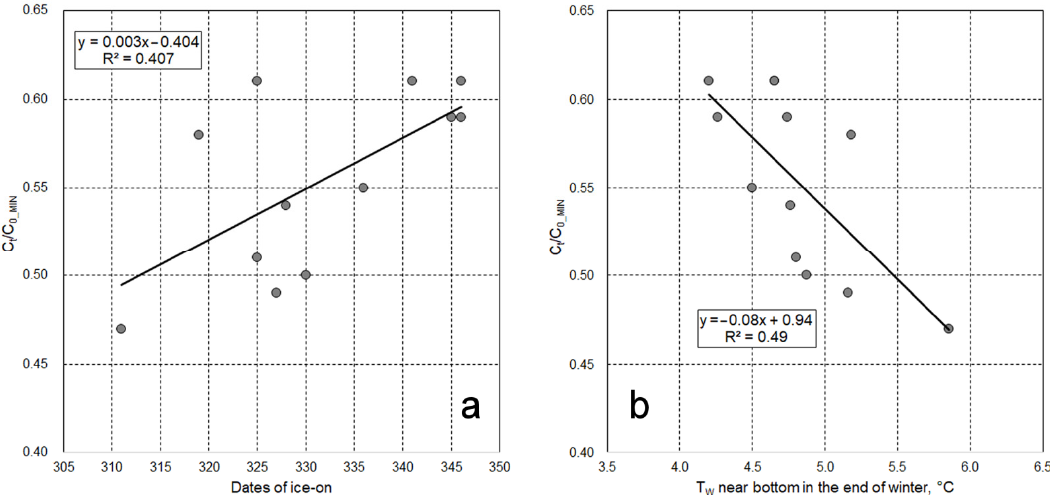
Figure 8. C t /C 0_PLUS at the end of the winter as a function of the date of under-ice convection onset ( a ), the duration of convection ( b ), the number of days with a positive air temperature in March–April ( c ), and the number of days with liq- uid or mixed precipitation in March–April ( d ). There are good correlations between C t /C 0_PLUS and dates of start convection ( p = 0.0139) and duration of convection ( p = 0.0042). The greatest increase in the oxygen con-